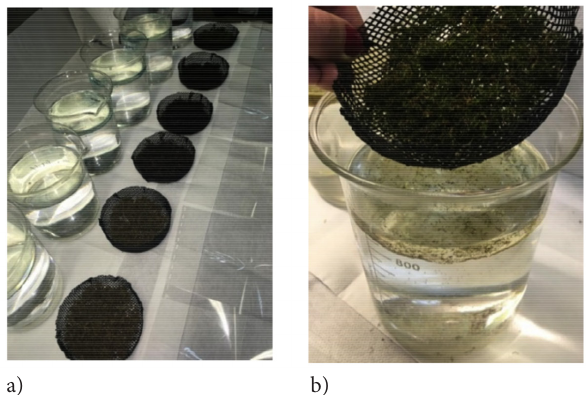
Figure 1. Diesel/water sorption test: a – beakers filled with liquid and sorbent in the mesh, b – liquid excess